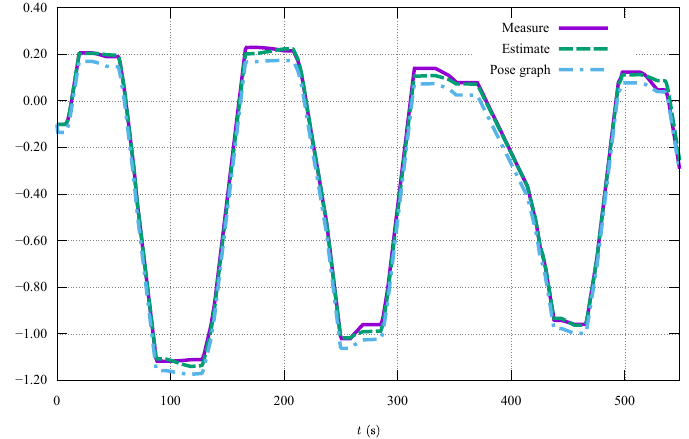
Figure 12. X -direction position of the robot. The robot’s positions in the horizontal direction during translational movement are adjusted by the loop